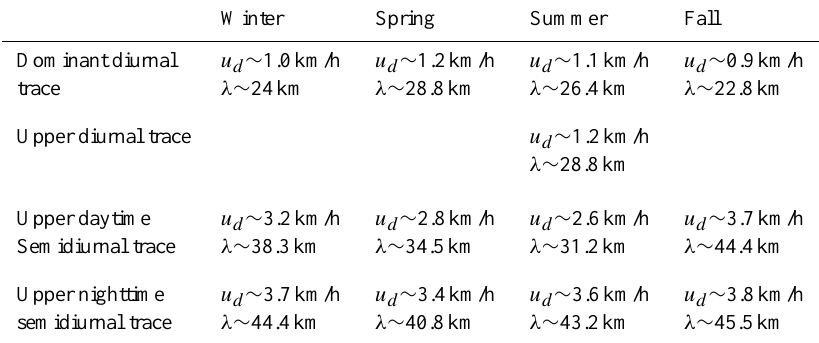
Semidiurnal trace